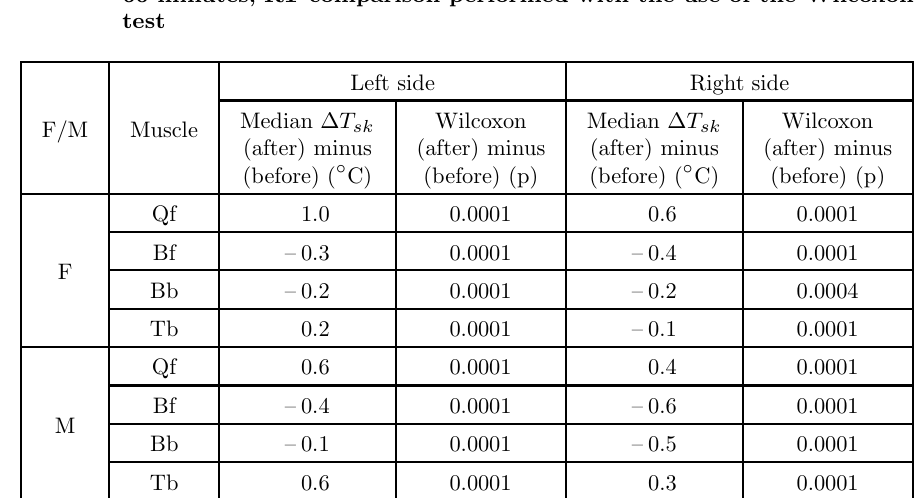
Table 5. ∆ T sk left and ∆ T sk right differences between ROIs after vs. before 60 minutes; RT comparison performed with the use of the Wilcoxon test Left side Right side Median ∆ T sk Wilcoxon Median ∆ T sk Wilcoxon F/M Muscle (after) minus (after) minus (after) minus (after) minus (before) ( ◦ C) (before) (p) (before) ( ◦ C) (before) (p) Qf 1.0 0.0001 0.6 0.0001 Bf – 0.3 0.0001 – 0.4 0.0001 F Bb – 0.2 0.0001 – 0.2 0.0004 Tb 0.2 0.0001 – 0.1 0.0001 0.6 0.0001 0.4 – 0.4 0.0001 – 0.6 – 0.1 0.0001 – 0.5 0.6 0.0001 0.3 Key: p – level of significance during the Wilcoxon pair difference test; the abbreviations used for the areas are clarified in the section describing methods (Table 2) The decrease in median ∆ T sk for the upper left and lower left extremi- ties is statistically significant for Bf, Bb in female and male subjects (– 0.3 ◦ C, – 0.2 ◦ C, p < 0 . 05 ; – 0.4 ◦ C, – 0.1 ◦ C, p < 0 . 05 , respectively), while the increase is statistically significant for Qf and Tb in both groups of subjects (1.0 ◦ C,